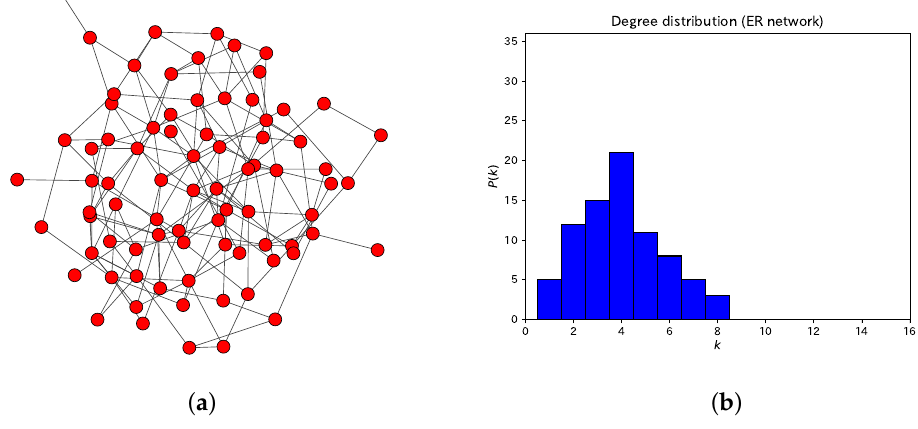
Figure 1. ER network; N = 80, (cid:104) k (cid:105) = 4. ( a ) Graph. ( b ) Distribution of degrees.